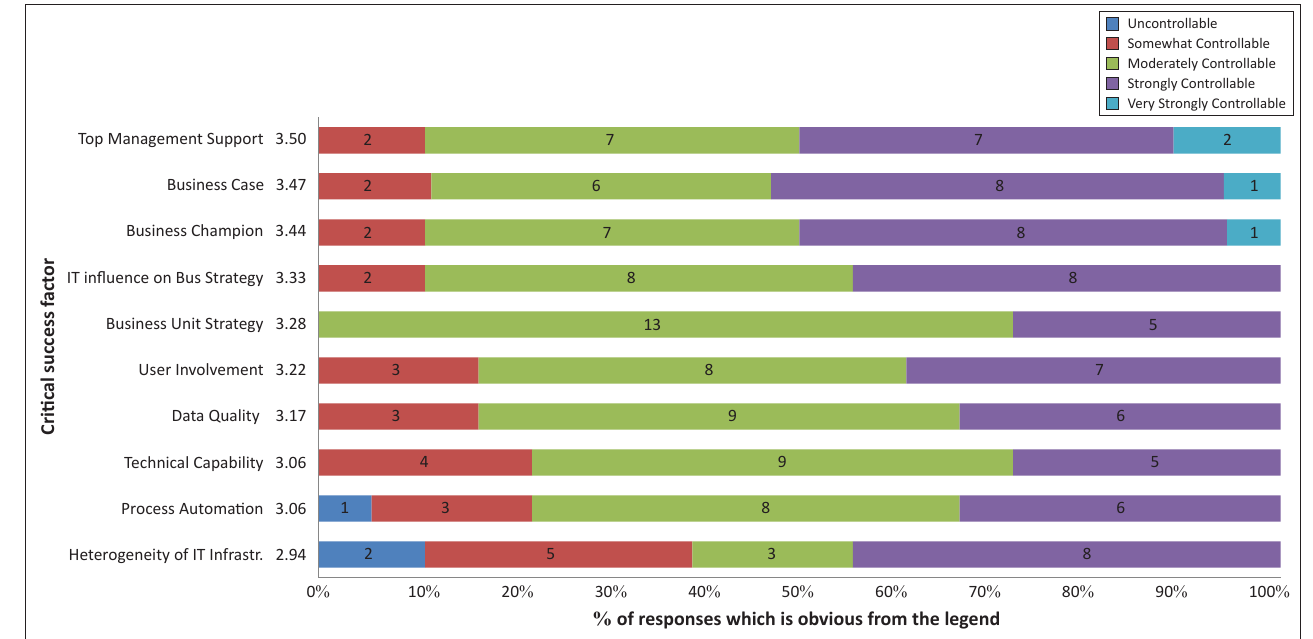
FIGURE 5: Perceived controllability of top critical success factors.